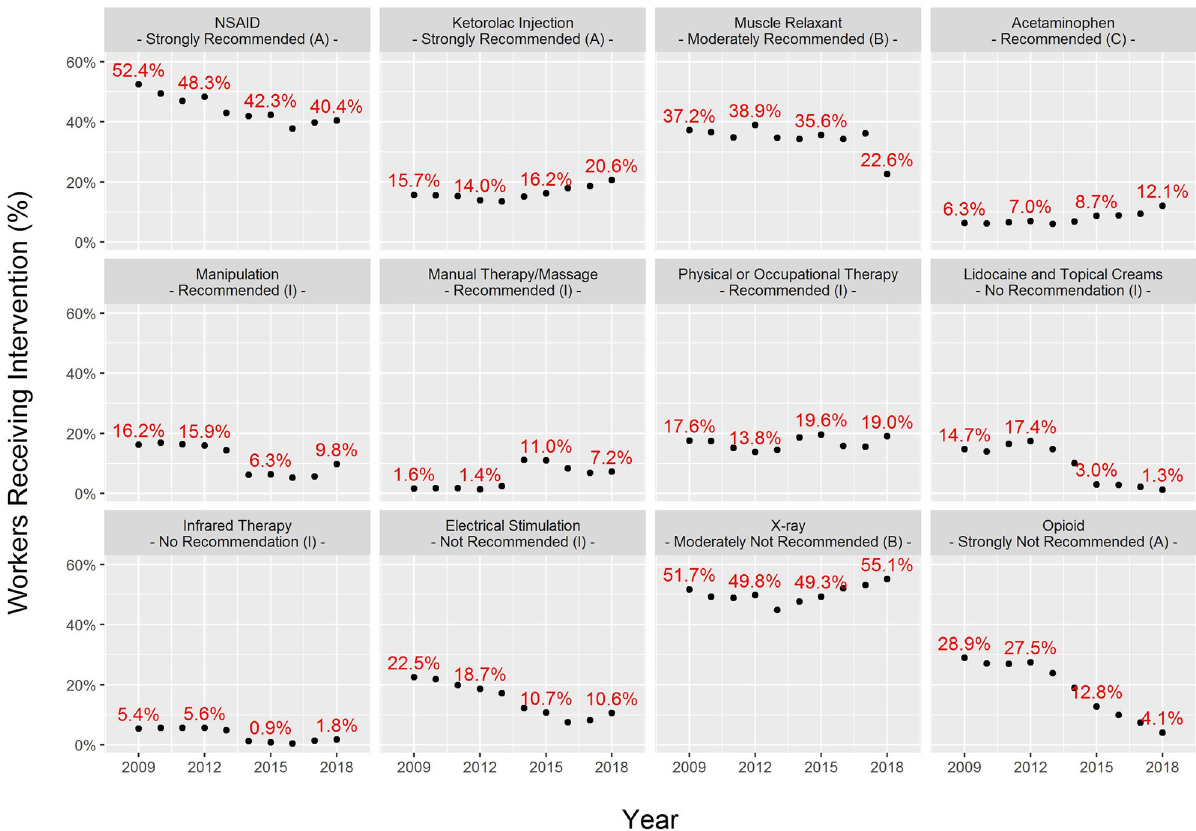
Fig 2. Percent of workers receiving intervention by year of injury.